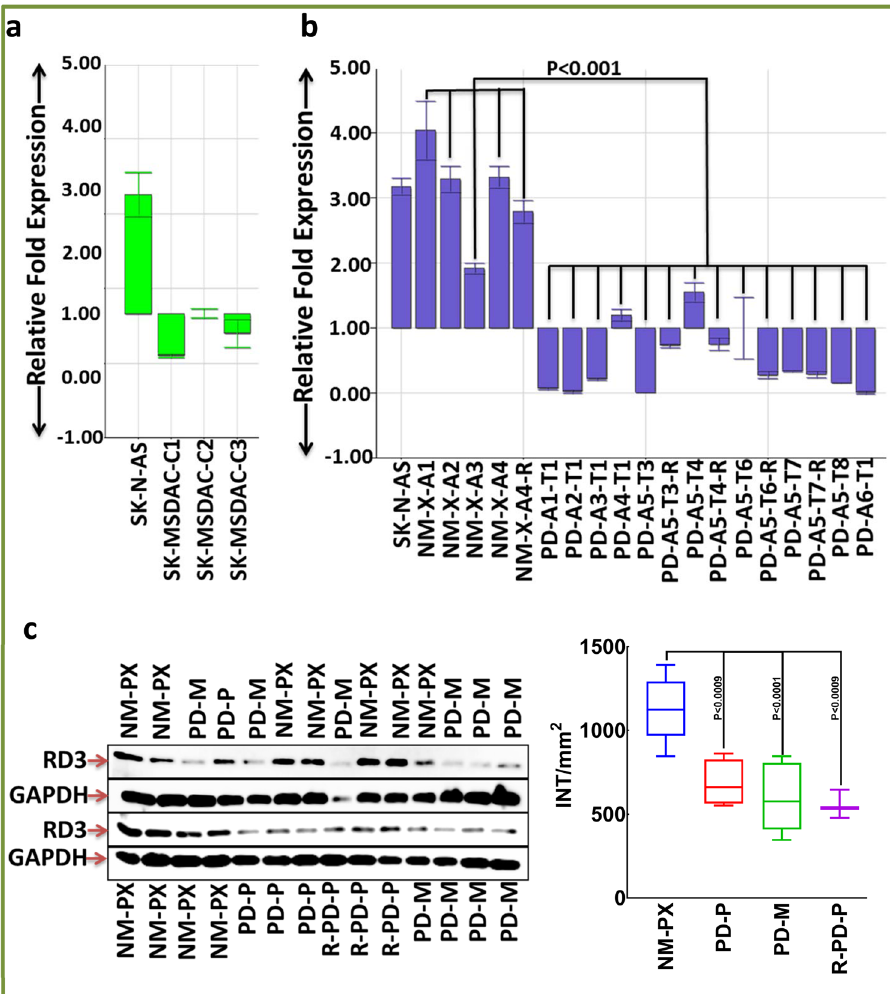
Figure 4. Loss of RD3 in a mouse model of progressive disease (PD) : ( a ) Histograms from QPCR analysis showing complete suppression of RD3-mRNA levels in the clones of SK-MSDACs grown ex vivo under stem cell culture conditions. ( b ) Histograms from QPCR showing complete loss of RD3 mRNA levels in tumors from primary and metastatic sites of mice with PD ( n = 6) compared with the primary xenografts from mice without PD ( n = 6). RD3 mRNA levels were compared between non-metastatic primary xenografts ( n = 4), metastatic lesions from animals bearing progressive disease ( n = 6), multi-metastatic lesions from the same animal ( n = 5), a reproduced non-metastatic xenograft ( n = 1), and reproduced progressive disease ( n = 3). Parental SK-N-AS cells are used for expression comparison. ( c ) Immunoblots showing consistent loss of RD3 in tumors from primary (Top panel) and metastatic sites (Bottom panel) of mice with PD compared with primary xenografts in mice without PD. Side panel . Band intensity analysis and group-wise comparison showing significant loss of RD3 in PD. Densitometry analyses were performed using Quantity One Image analysis software and were compared using GraphPad PRISM. NM , non-metastatic ; PD , progressive disease ; A , animal ; T , tumor ; X , primary xenograft ; R , reproduced disease ; P , tumor from primary site ; M , tumor from metastatic site . Full-length blots are presented in Supplementary Fig.